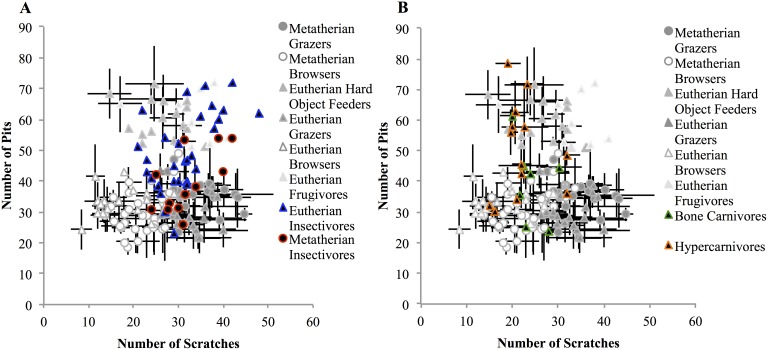
Microwear results of insectivores (A) and carnivores (B) plotted with herbivorous taxa.Marsupial and placental insectivore groups are not significantly different (p = 0.65), nor are hypercarnivores (flesh eaters) and bone carnivores (chew and consume bone) (see Table S5 in Supporting Information S1 for details). Regardless of feeding preferences, both flesh and bone specialists consume both types of food, depending on availability, the season, the animal’s status in social groups, and other factors, resulting in a lack of further differentiation.